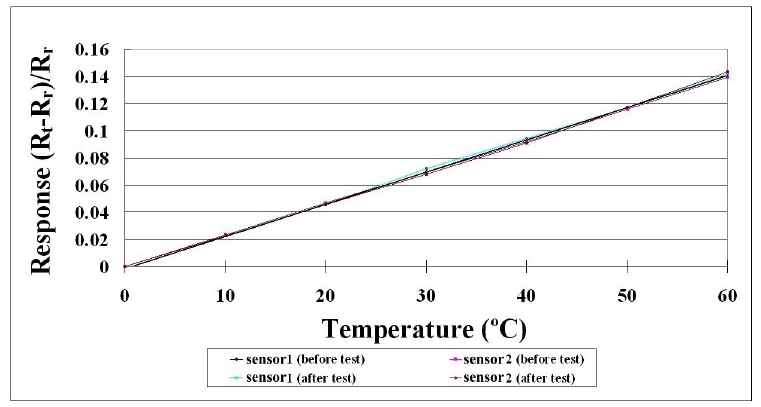
Figure 11. Microsensor temperature correction curve before and after coin cell charge-discharge